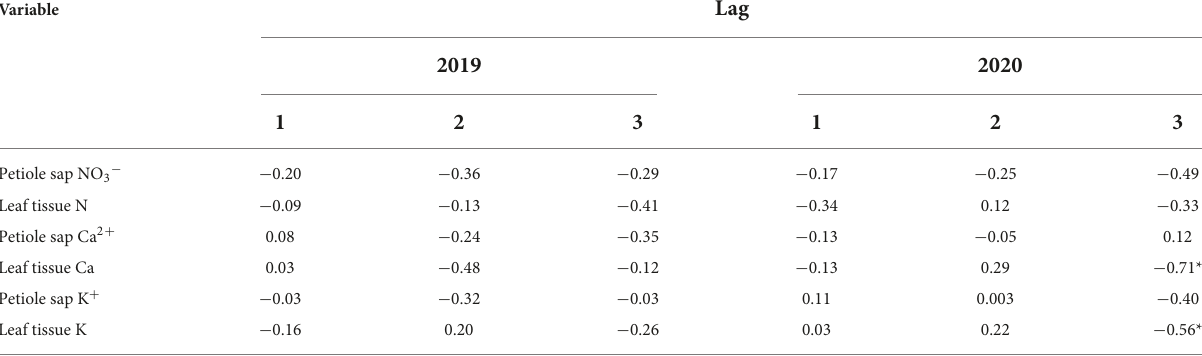
TABLE 8 Pearson correlation coefficients (r), linear regression coefficients of determination (R 2 ), and P -values of each paired variable in 2020.